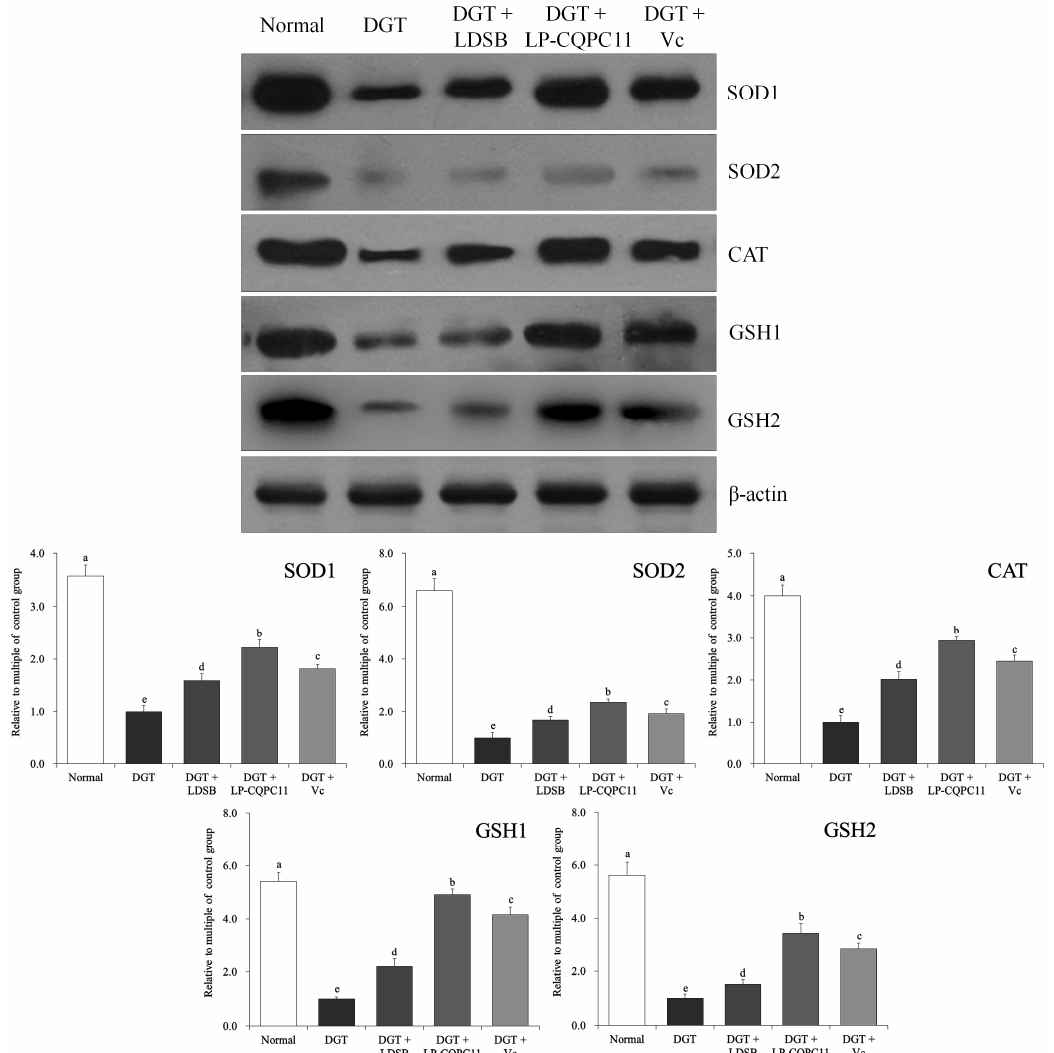
Figure 6. The protein expression in liver of mice. a–e The different letters mean that there are significant differences ( p < 0.05) between every two groups according to Duncan’s multiple range test. DGT: mice treated with D -galactose; DGT + LDSB: mice treated with D -galactose and Lactobacillus delbruechii subsp. bulgaricus (1.0 × 10 9 CFU/kg); DGT + LP-CQPC11: mice treated with D -galactose and Lactobacillus plantarum CQPC11 (1.0 × 10 9 CFU/kg); DGT + Vc: mice treated with D -galactose and vitamin C (200 mg/kg).